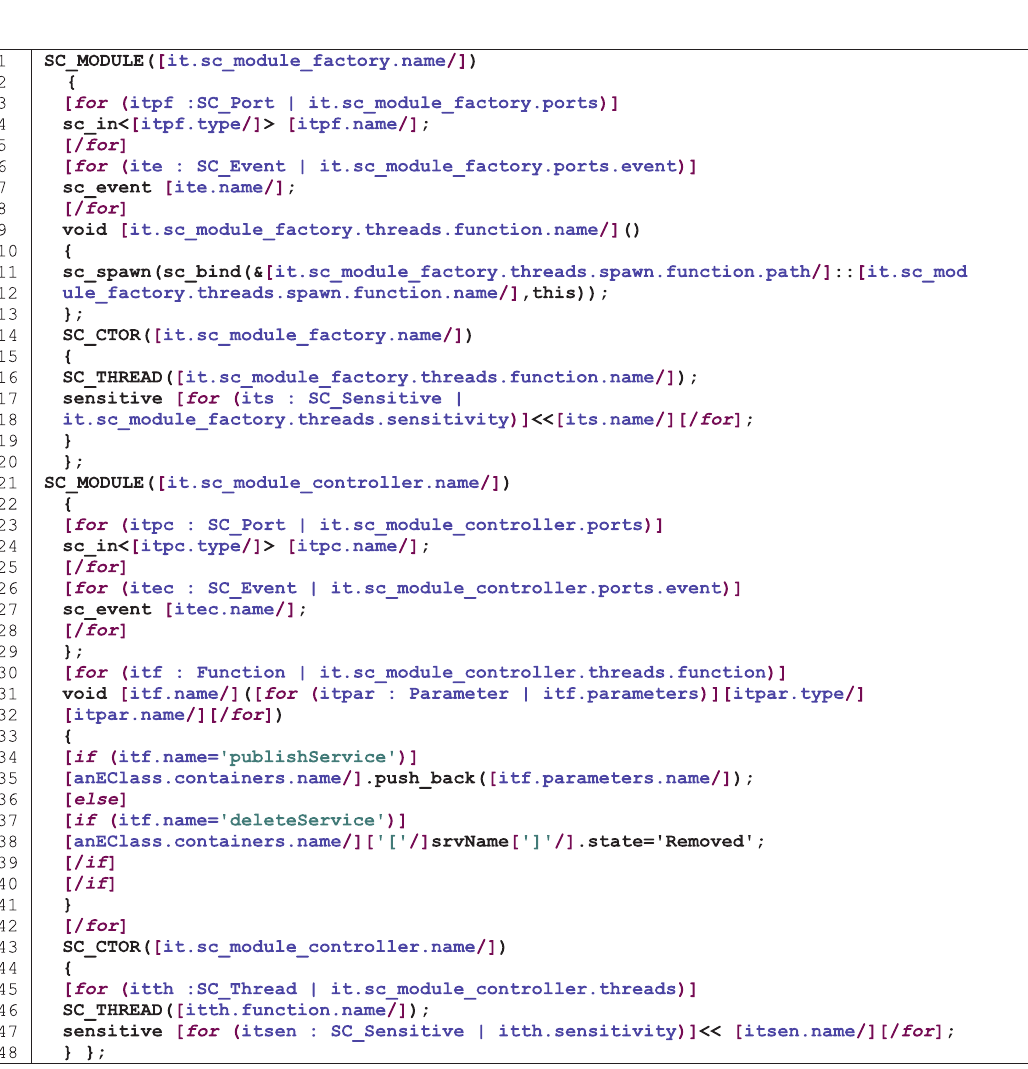
Figure 22: Part of the template for SystemC/TLM code generation. Table 5: The measurement results of the hand-coded